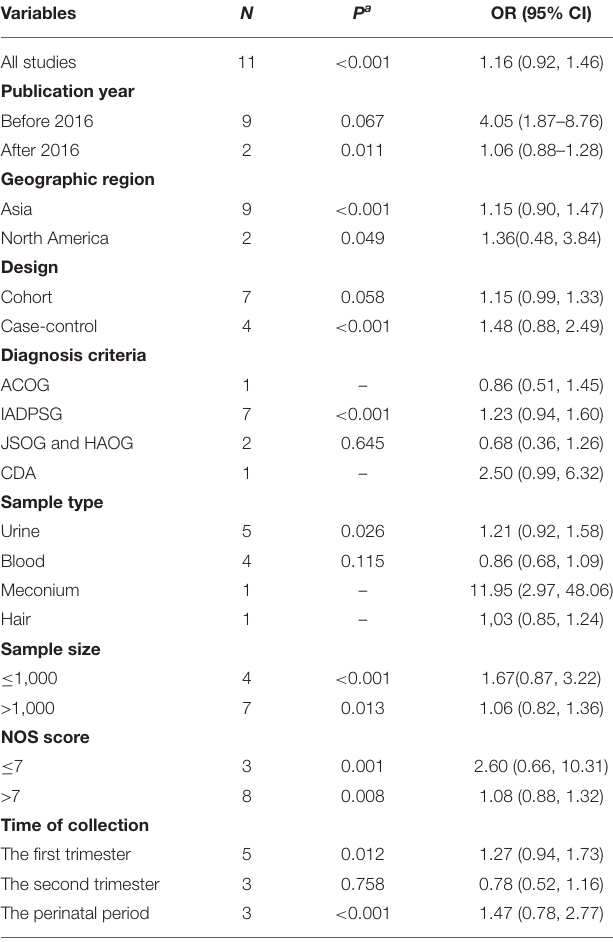
TABLE 3 | Results of the subgroup analysis for the associations of cadmium exposure with GDM